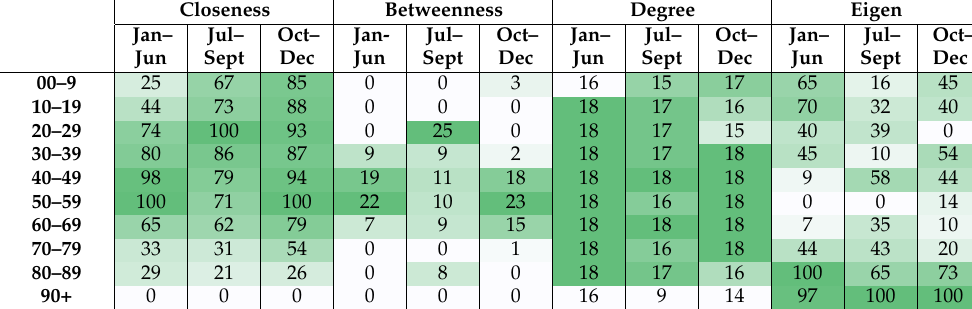
Table 6. Centrality Measures of the digraph related to the Age groups Jan–Jun, Jul–Sept and Oct– Dec time intervals of 2021.